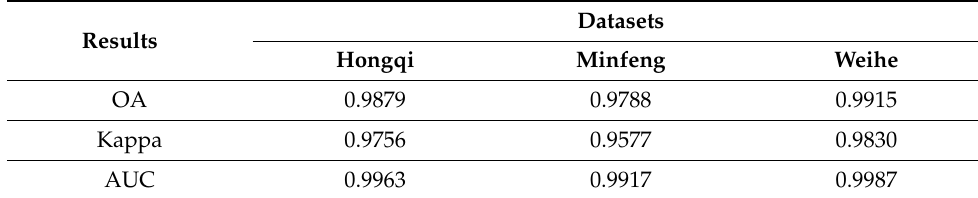
Table 4. Results for the validation